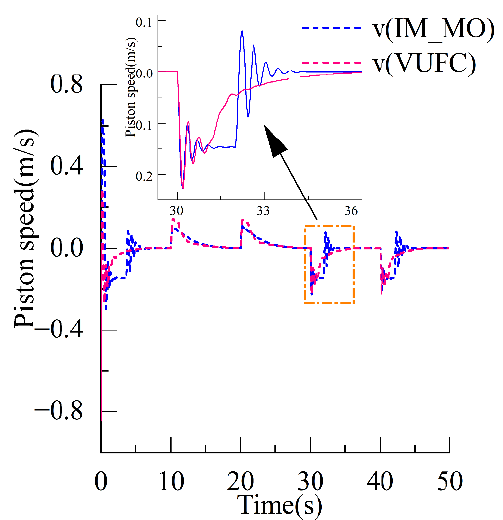
Figure 18. Velocity of the hydraulic cylinder.